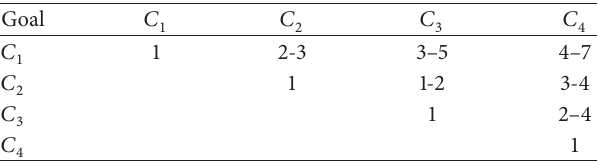
Table 1: Interval pairwise comparisons of criteria (Example 1).